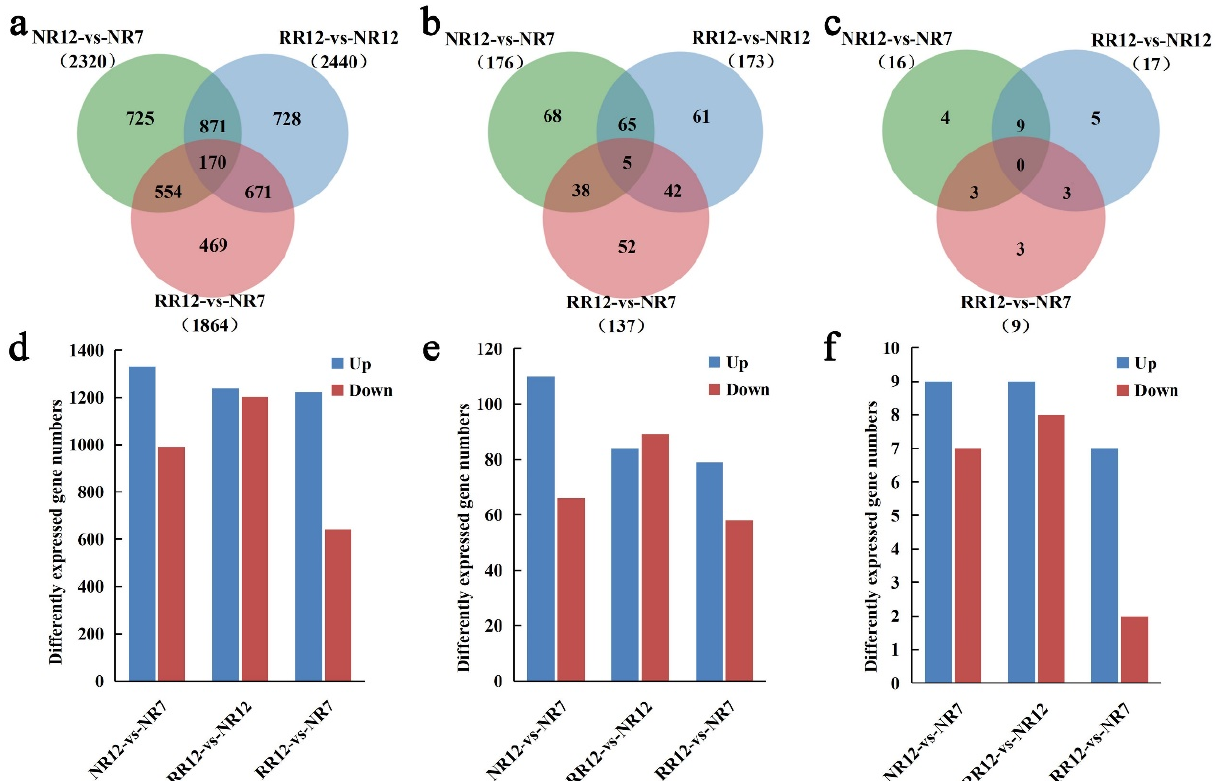
Figure 5. Comparative analysis of mRNAs, lncRNAs, and circRNAs. The specific mRNAs ( a ), lncRNAs ( b ), and circRNAs ( c ) shared by three comparison groups (NR12_vs_NR7, RR12_vs_NR7, RR12_vs_NR12). The mRNAs ( d ), lncRNAs ( e ), and circRNAs ( f ) differentially expressed in various sample groups.